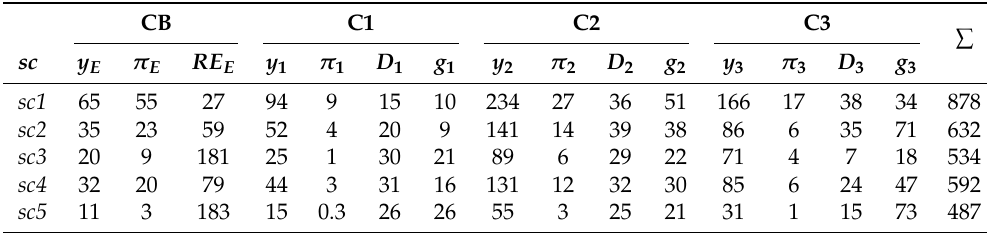
Table 10. Detailed objective function values, robustness experiment ‘exp1’.